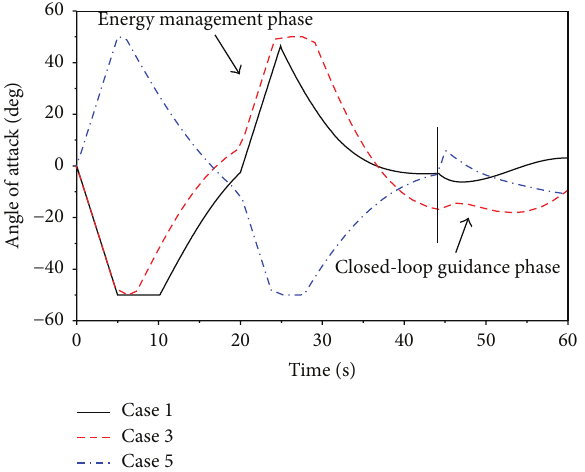
Figure 12: Excess velocity versus time. Table 5: Dispersions used in Monte Carlo simulations.